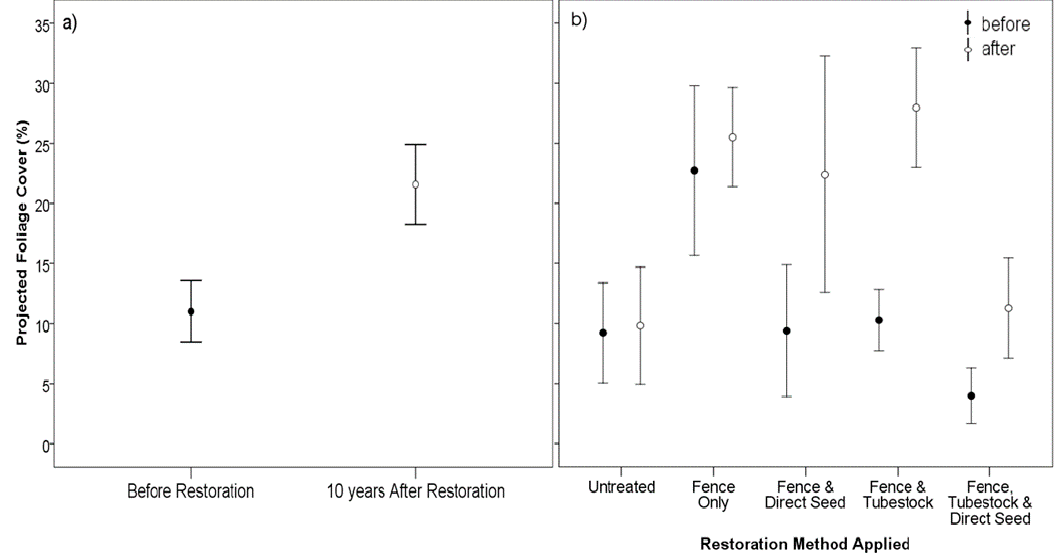
Figure 5. Changes in projective foliage cover from aerial photographs of sites before restoration occurred and 10 years after. Mean projected foliage cover ( a ) across all treated sites and, ( b ) for untreated sites and sites restored using each of the four di ff erent restoration methods. Closed circles ( (cid:8) ) = before restoration, and open circles ( ) = 10 years after restoration. Error bars represent ± (cid:35)